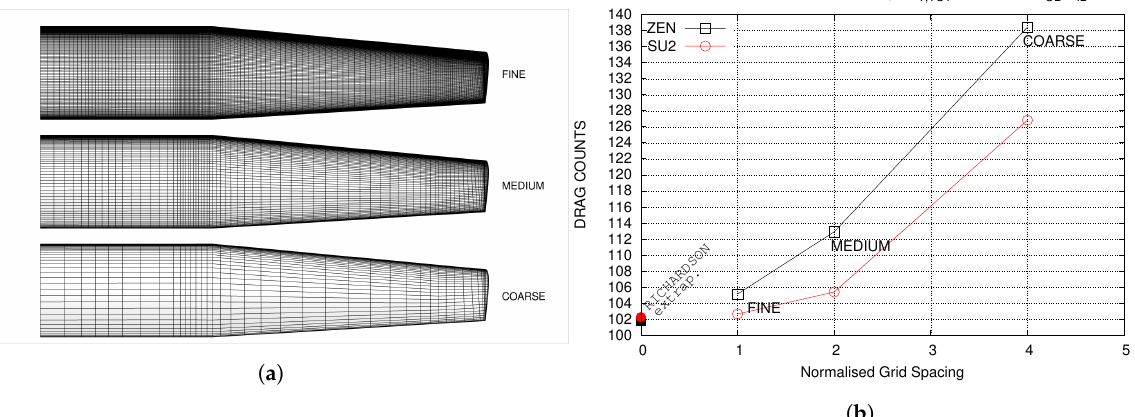
Figure 5. FVM computations at different grid levels ( M = 0.480; Re = 16.6 × 10 6 ; AoA = − 2°): ( a ) Wing surface mesh in coarse, medium and fine grid levels; ( b ) Grid convergence of drag